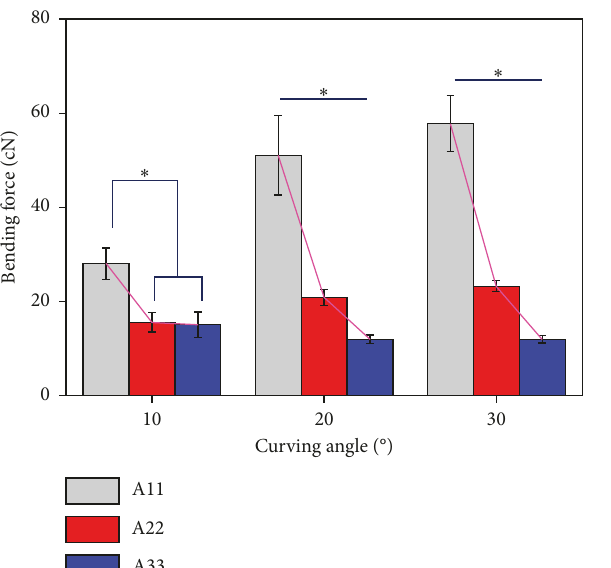
Figure 8: Bending force of stent grafts C13 and C23 given the same curving